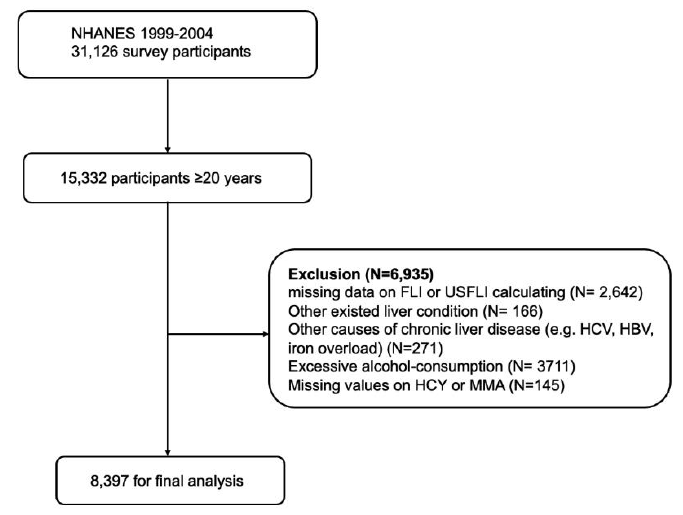
Figure 1. Inclusion algorithm.